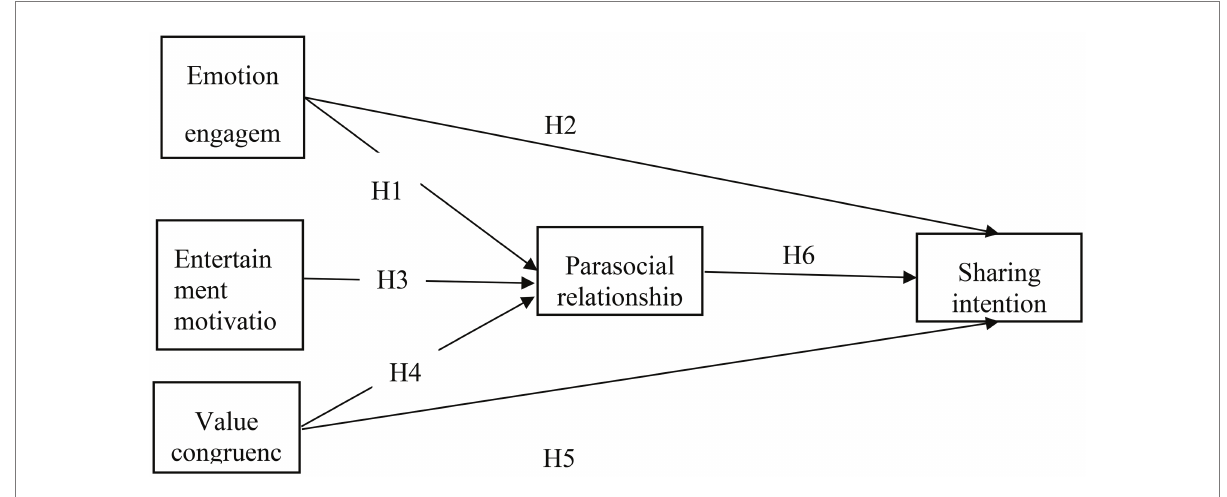
FIGURE 1 Proposed research